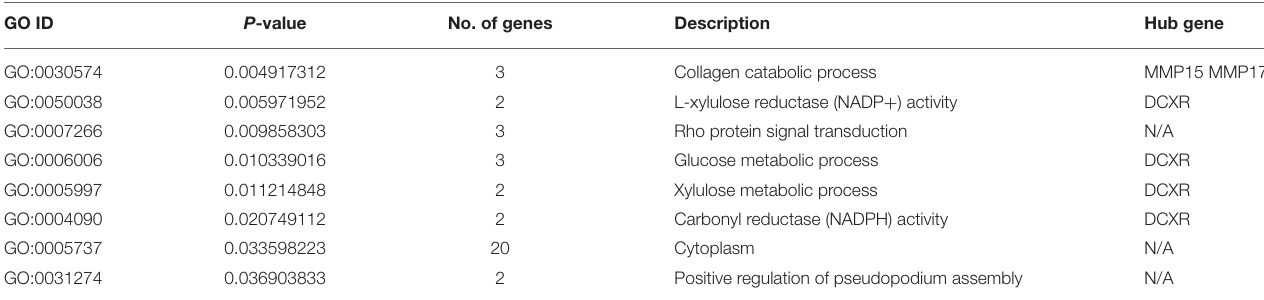
TABLE 1 | Most significant GO terms of the turquoise